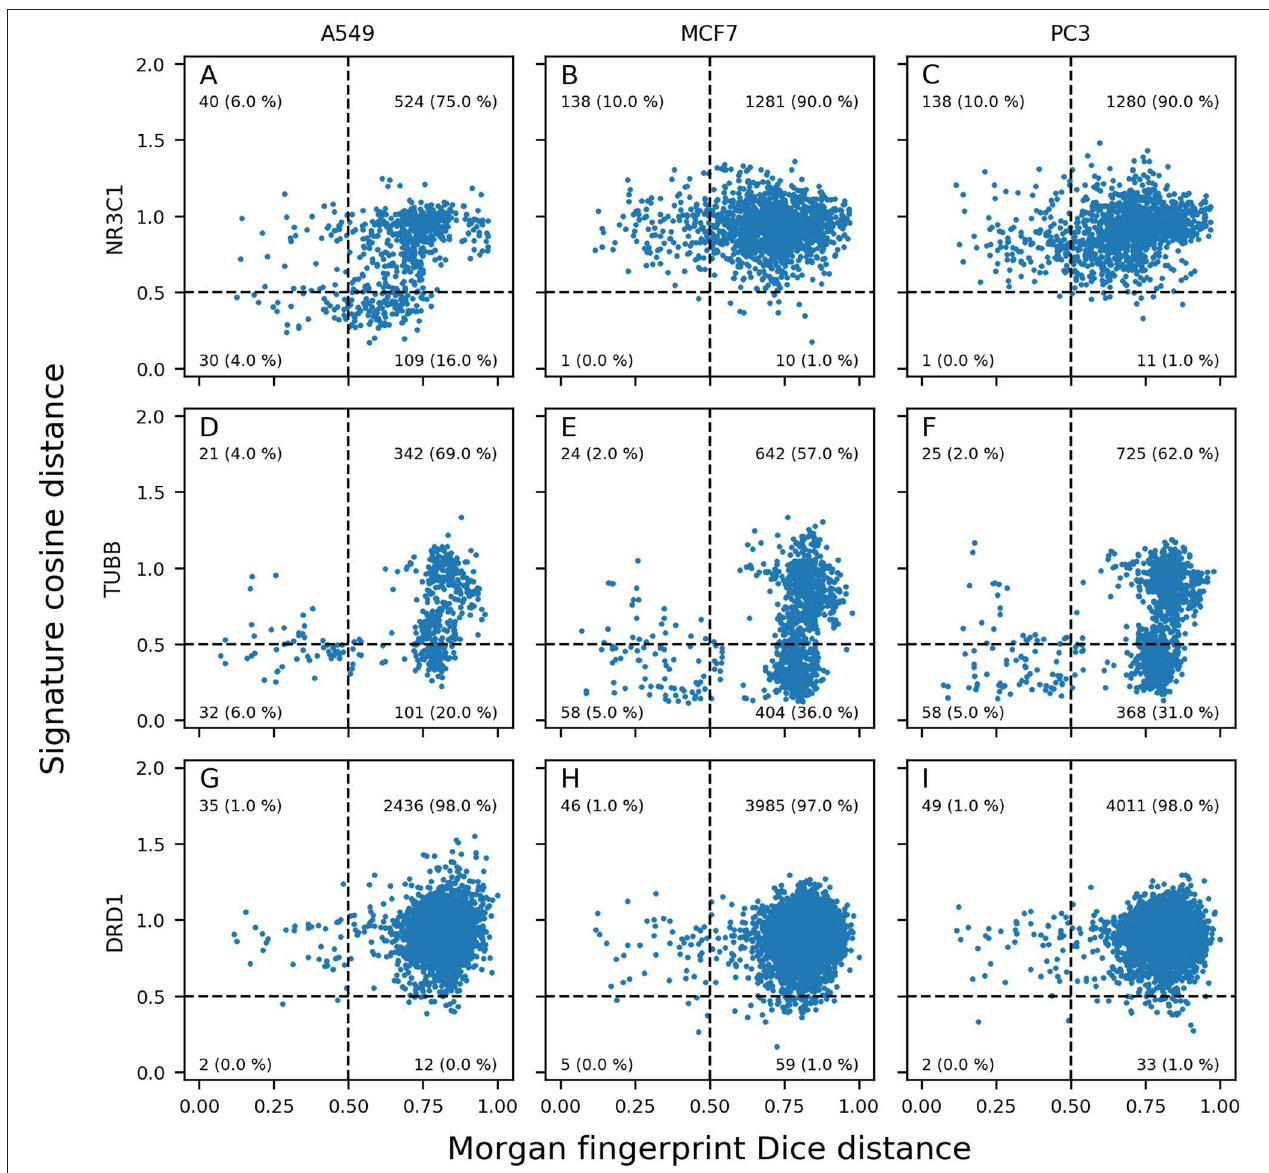
FIGURE 6 | Morgan fingerprints Dice distance vs. GES cosine distance (distance plots). Different panels show information for pairs of NR3C1 (A–C) , TUBB (D–F) , and DRD1 (G–I) ; active compounds in A549 (A,D,G) , MCF7 (B,E,H) , and PC3 (C,F,I) cell